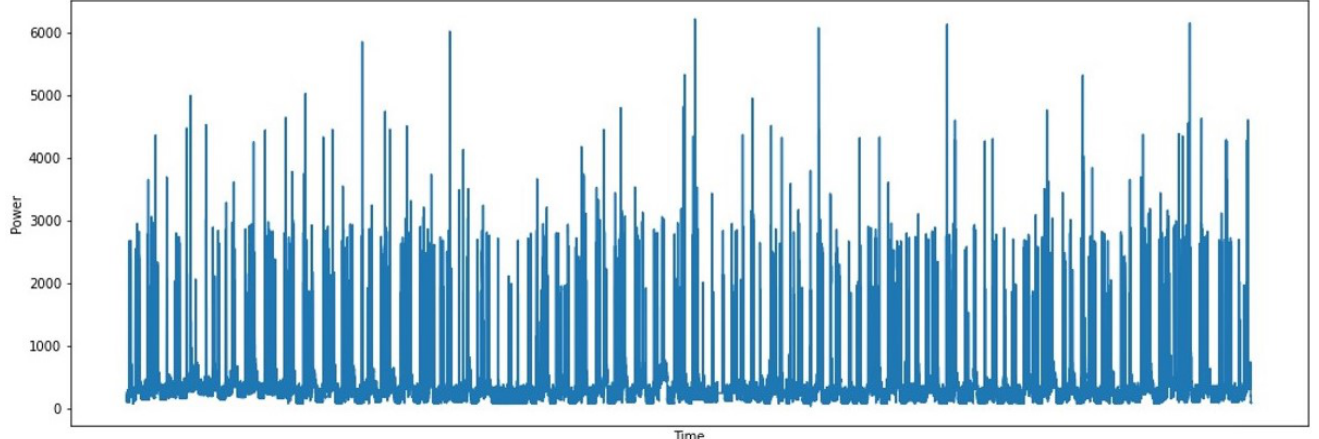
Figure 2. A power signature in a time